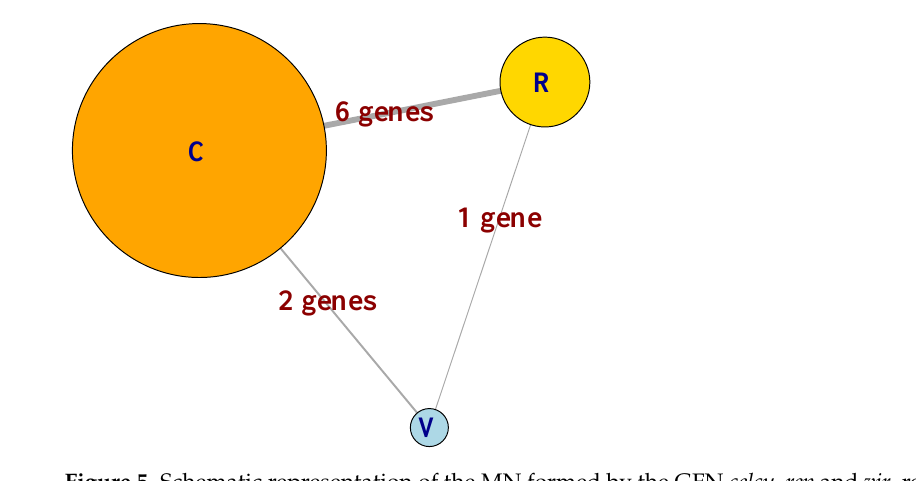
Figure 5. Schematic representation of the MN formed by the GFN celcy , rep and vir , represented as the circles labeled as C , R and V , respectively. Sizes of circles are proportional to the number of genes at each GFN and links are annotated with the number of genes shared between pairs of